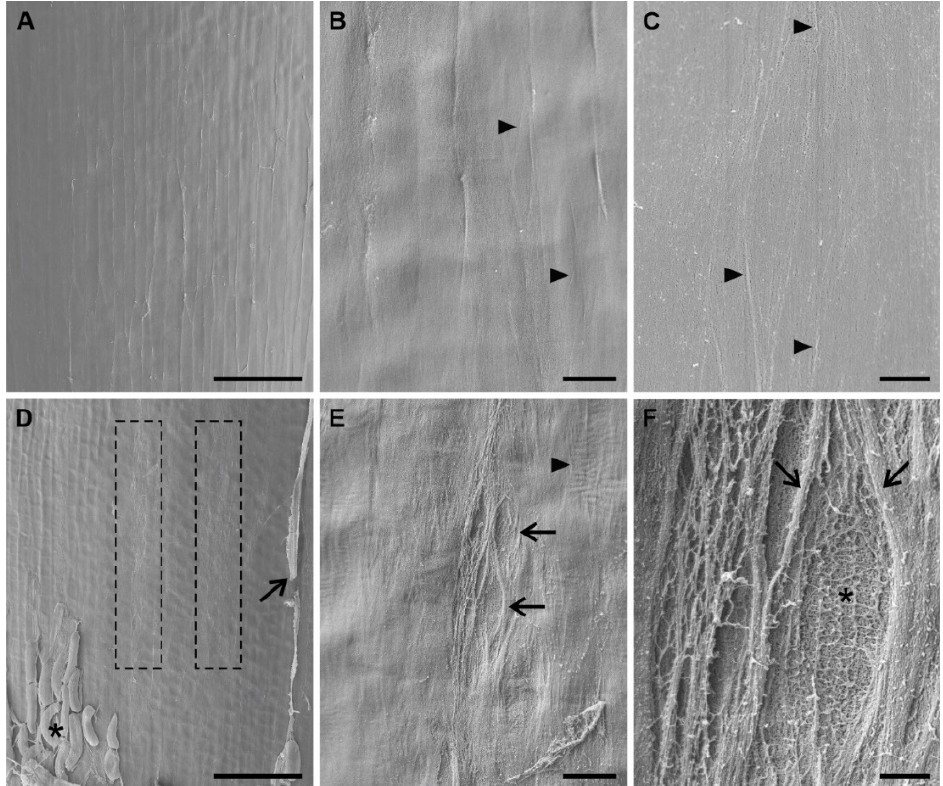
Figure 9. SEM micrographs of the epidermal surface of maize roots up to 1 mm from the root tip. ( A – C ) Control roots with smooth surface; arrowheads in ( B , C ) indicate fine regularly arranged fibrils. ( D – F ) Stressed roots with locally damaged, torn-like surface ( D , frames). ( E ) Enlarged view of the left framed area in ( D ) with fusiform tears arranged along the root axis (arrows) and local transverse wrinkles (arrowhead). ( F ) Detailed view of the fibril arrangement around (arrows) and inside (asterisk) the tear. Asterisk and arrow in ( D ) indicate loose root cap cells and bands of mucilage, respectively. All image orientation is parallel to the root axis. Scale bars: 100 μm ( A , D ), 10 μm ( B , E ), 2 μm ( C , F ).